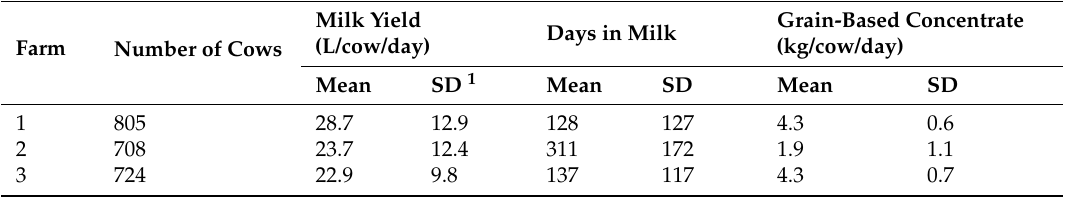
Table 2. The number of cows, milk yield (L/cow/day), days in milk (DIM), and grain-based concentrate offered (kg/cow/day) for three focal farms from Tasmania at the start of experiment